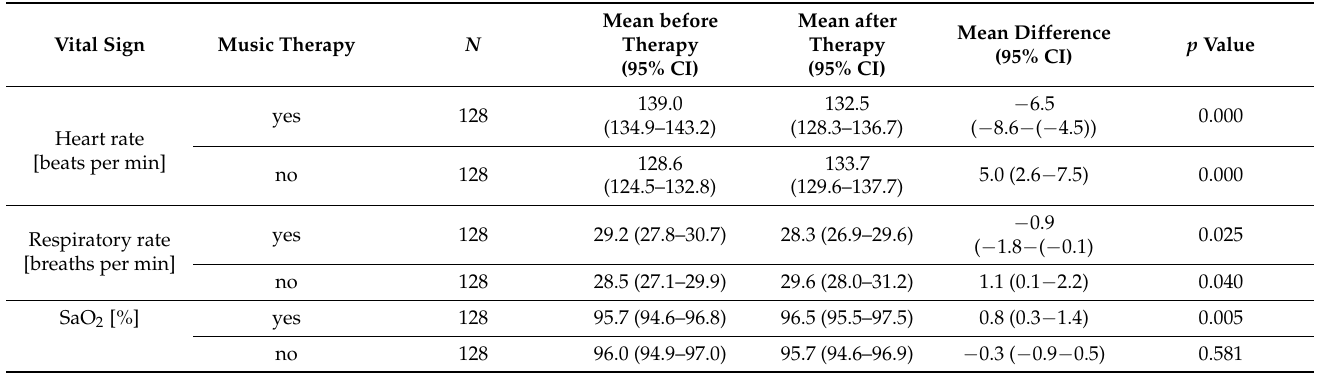
Table 3. Heart rate, respiratory rate and oxygen saturation before and after physical therapy sessions with and without music